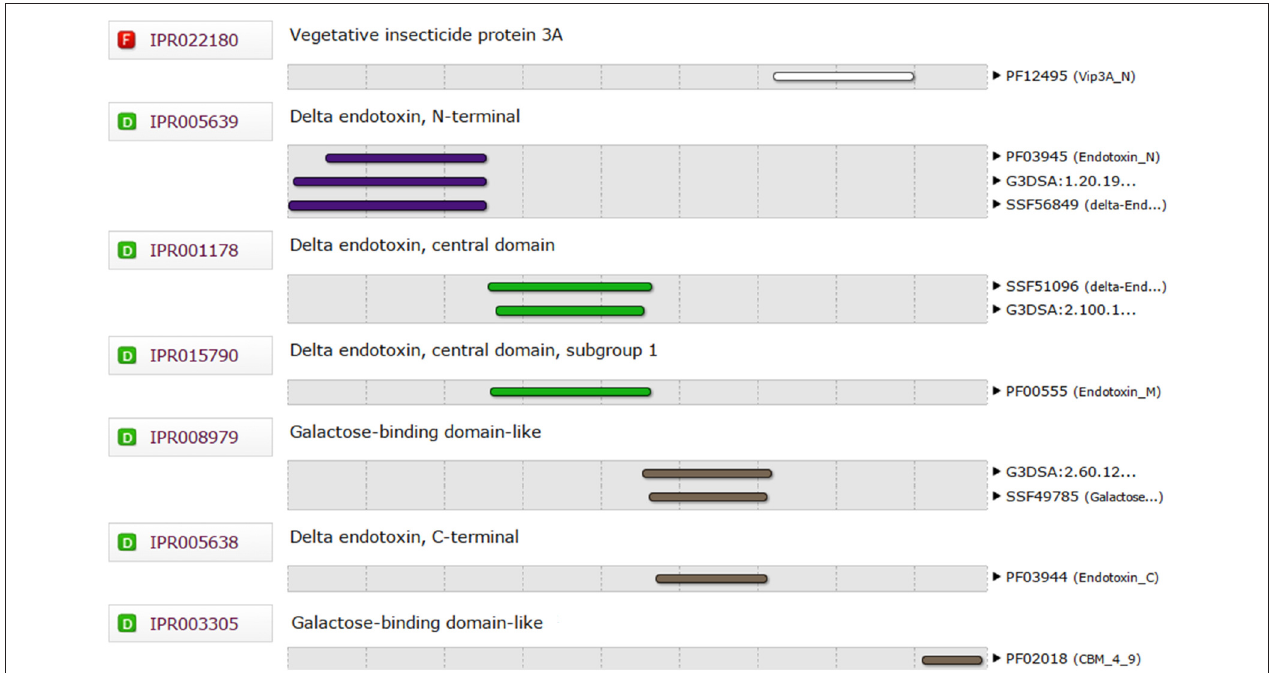
FIGURE 1 | Functional domains analysis of Cry1Ac-Vip3Aa fusion protein sequence through InterPro.